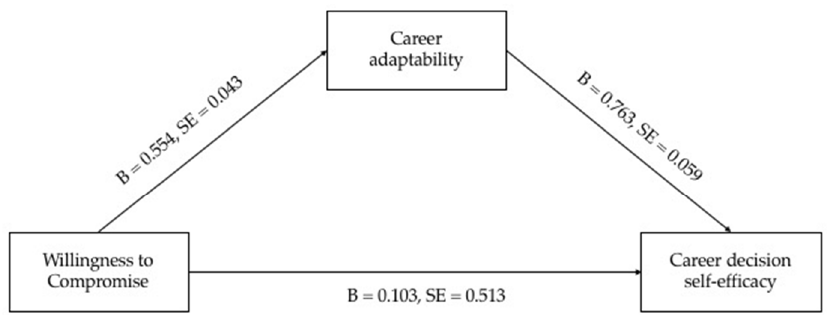
Figure 3. Mediation